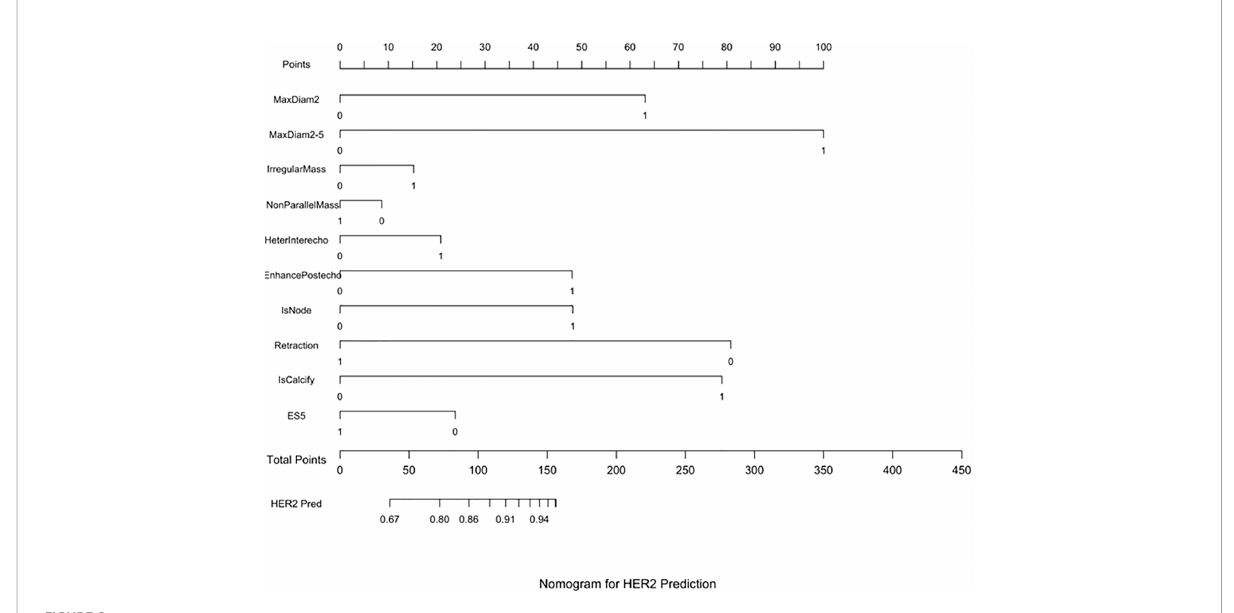
FIGURE 2 HER2 prediction nomogram. Nomograms were constructed based on the results of the multivariate logistic regression mode factors.